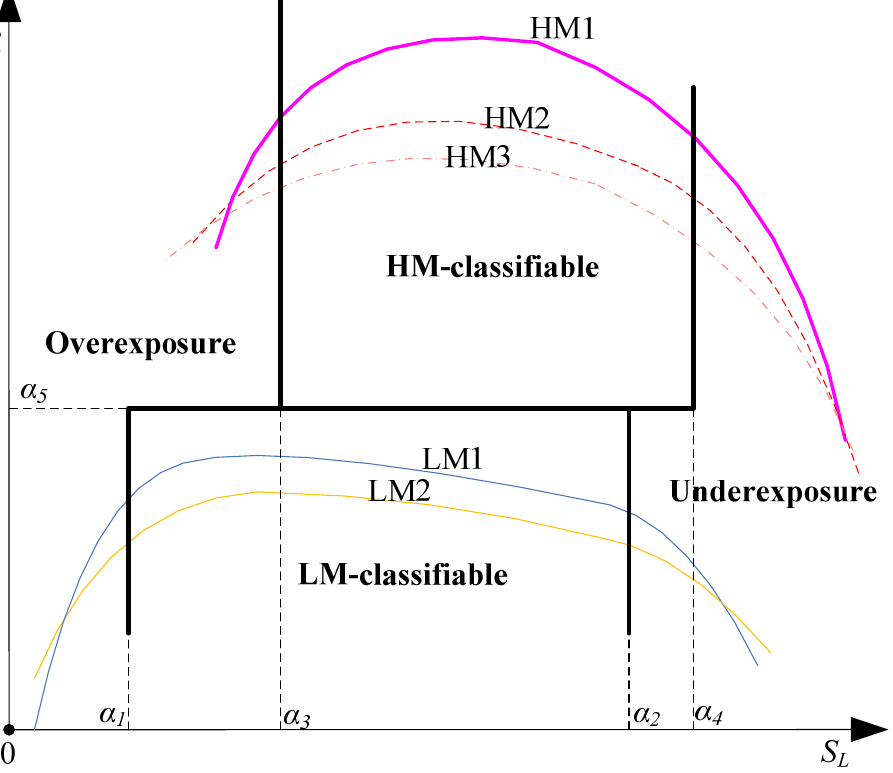
Figure 4. Diagrammatic sketch of identification by SL-R of DE-XRT.